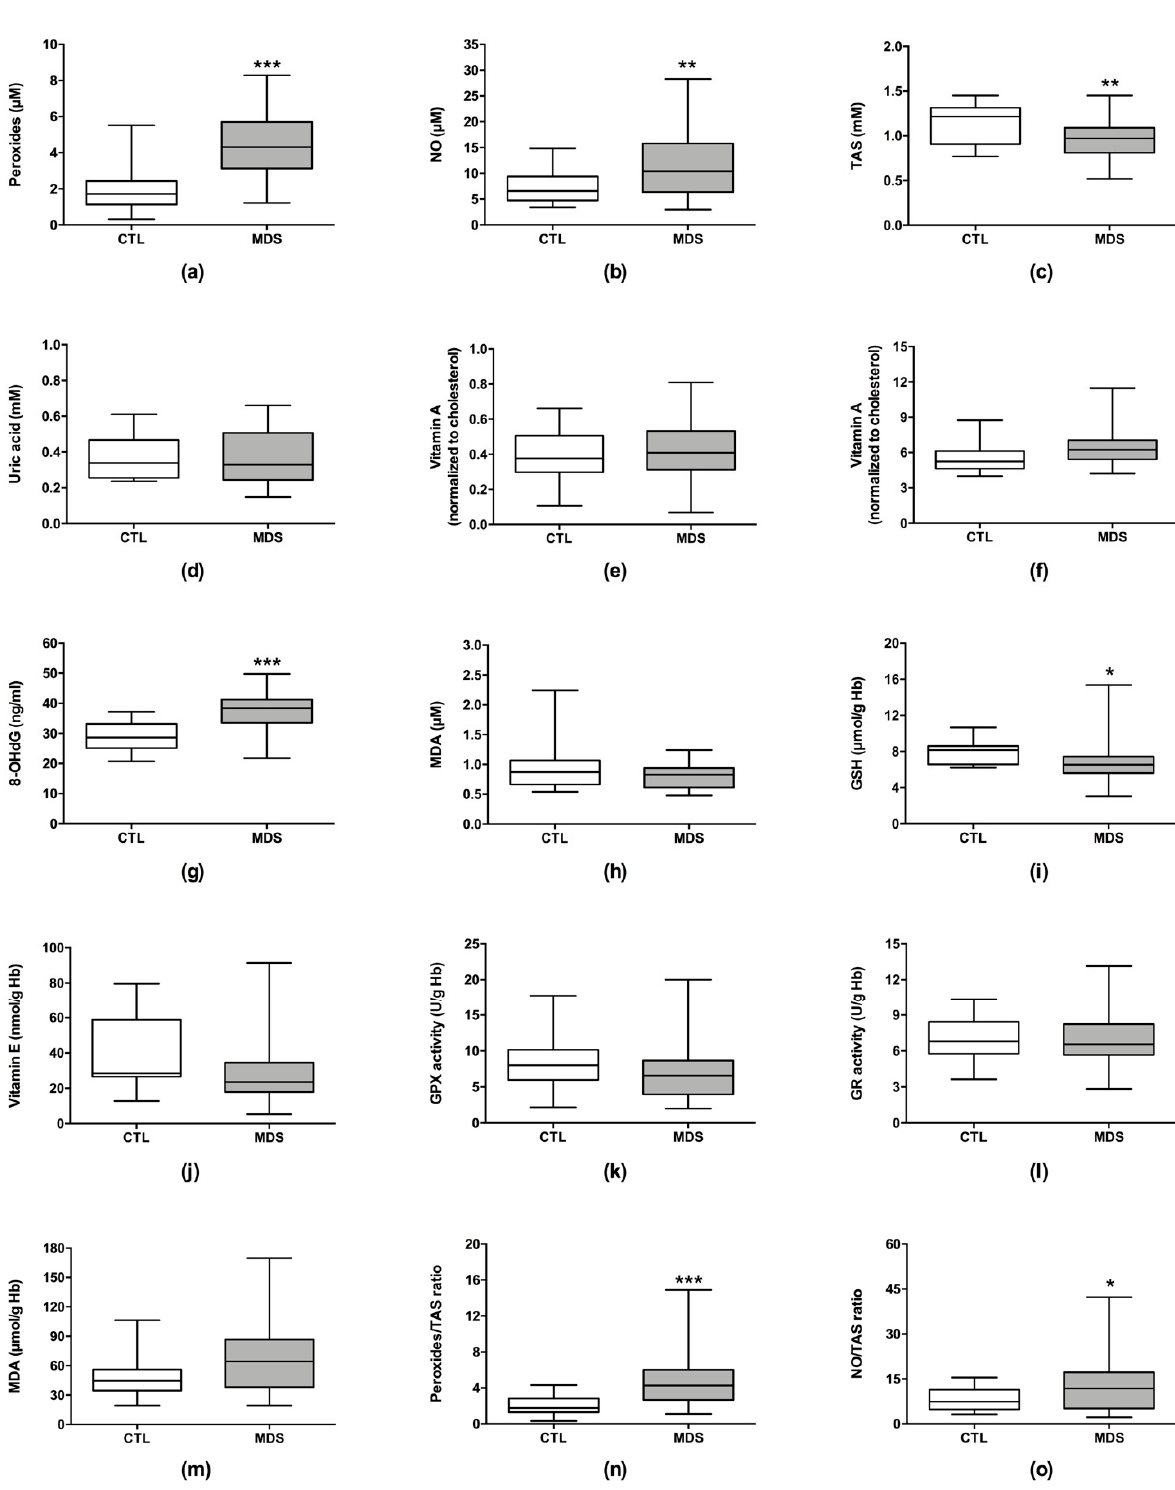
Figure 1. Analysis of plasmatic and erythrocyte oxidative stress parameters in myelodysplastic syndrome patients and controls. The following plasmatic oxidative stress levels are represented: ( a ) peroxides, ( b ) nitric oxide (NO), ( c ) total antioxidant status (TAS), ( d ) uric acid, ( e ) vitamin A, ( f ) vitamin E, ( g ) 8-hydroxy-2-deoxyguanosine (8-OHdG), ( h ) malondialdehyde (MDA), ( n ) peroxide/TAS ratio, and ( o ) NO/TAS ratio. Additionally, the following erythrocyte oxidative stress levels are represented: ( i ) reduced glutathione (GSH), ( j ) vitamin E, ( k ) glutathione peroxidase (GPX) enzymatic activity, ( l ) glutathione reductase (GR) enzymatic activity, and ( m ) MDA. *, p < 0.050; **, p < 0.010; ***, p < 0.001.